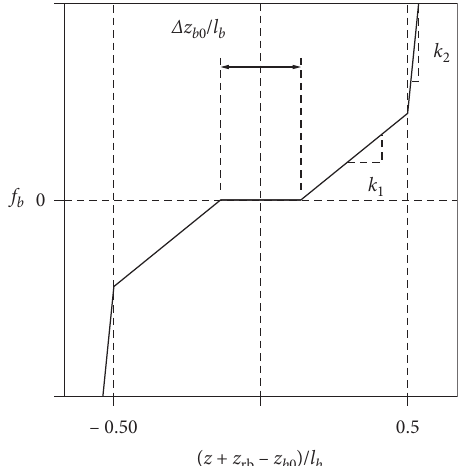
Figure 15: Bearing axial